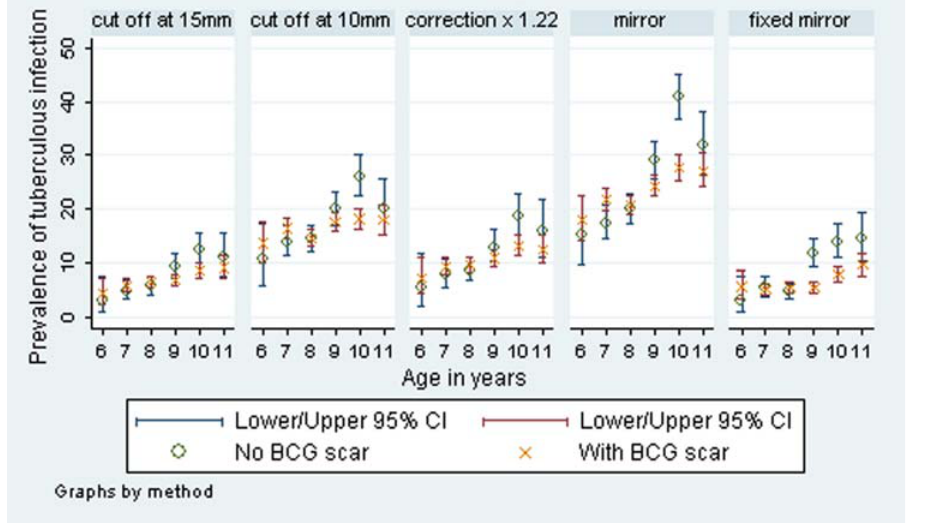
Figure 3. Prevalence of tuberculous infection with 95% binomial exact CIs, as calculated using five methods, by BCG and age for Zambia.